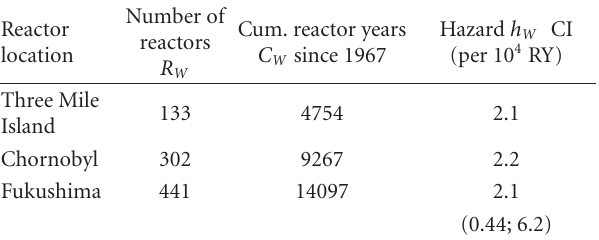
Figure 1: Cumulative number and cumulative years of experience for reactors connected to the grid until the end of 2010: reactor numbers in the years 1979, 1986, and 2011 with accidents of INES levels ≥ 5 are annotated. Table 2: Worldwide number R W of reactors at the time of accident, cumulative reactor years since 1967 and hazard for NPP reactor accidents with INES level ≥ 5 (95% CI in brackets are calculated only for the latest value based on three